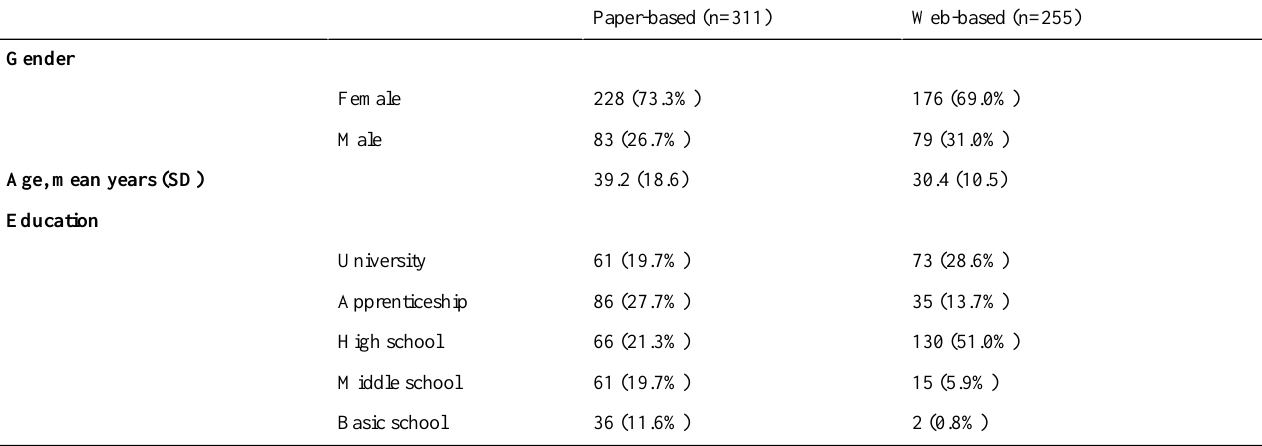
Table 1. Demographic characteristics of the paper-based and Web-based samples.